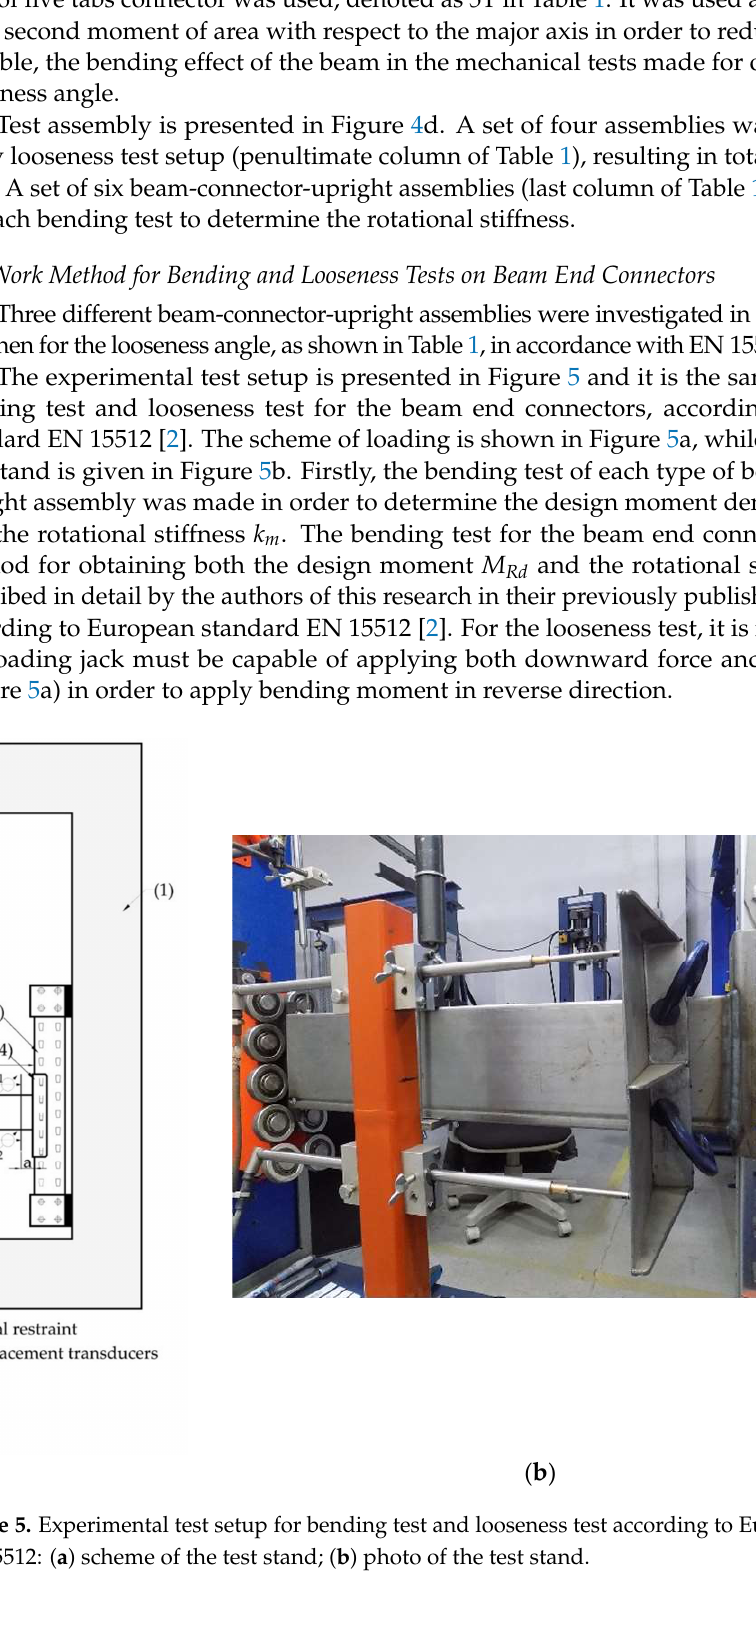
Figure 6. Typical moment rotational curve as test output to determine the looseness angle 𝛷 𝑙 . All moment rotation (𝑀 − 𝜃) curves obtained for the beam-connector-upright as- semblies involved in this research are reported as results. The paper also reports the fol- lowing data obtained by processing of the experimental data: looseness angle 𝛷 (cid:3039) , design moment M Rd , and rotational stiffness k m . 2.3. Theoretical Approach In fact, the looseness effect is caused by the gap between the width of the metallic tabs of the connector and the width of the slots located on the upright front side. In Fig- ure 7, it is shown how the effect of looseness affects the real deflection of the beams in operation on storage systems. The beam shape before deformation is drawn with a con-